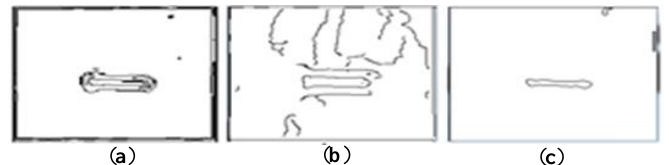
Figure 23. Notch edge detection, obtained with the ( a ) gradient magnitude, using Sobel’s gradient, ( b ) Canny edge detection algorithm, and ( c ) the developed fuzzy c-mean thresholding algorithm.